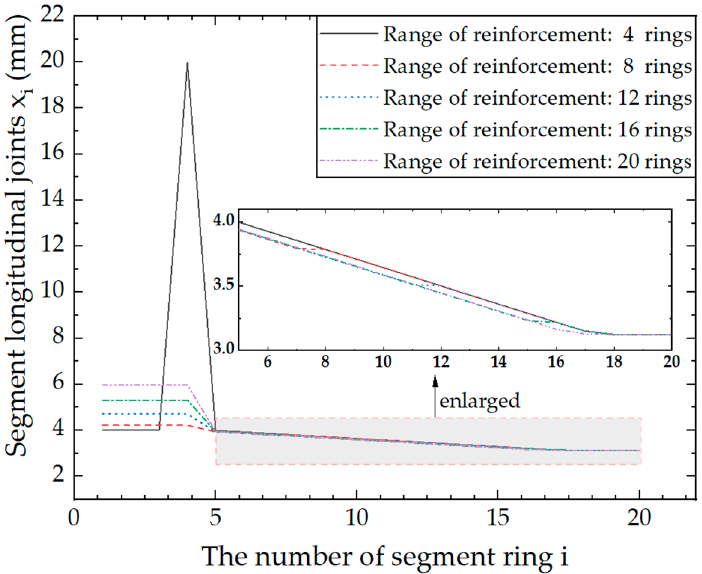
Figure 13. The relationship curve between the opening of circumferential joints and the number of rings under different reinforcement ranges.